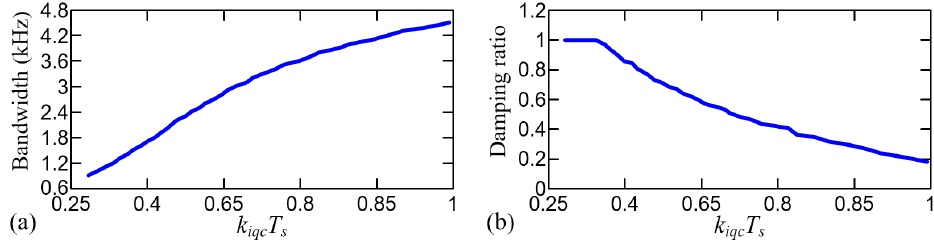
Figure 5. The ( a ) bandwidth and ( b ) damping ratio of the current estimator at different integral gain.